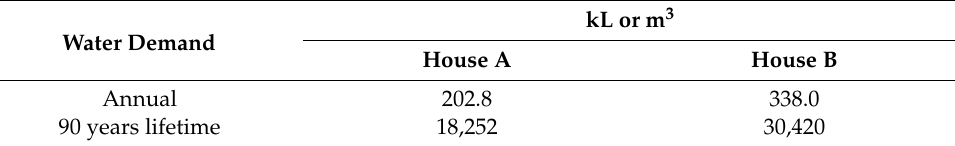
Table 4. Operational water